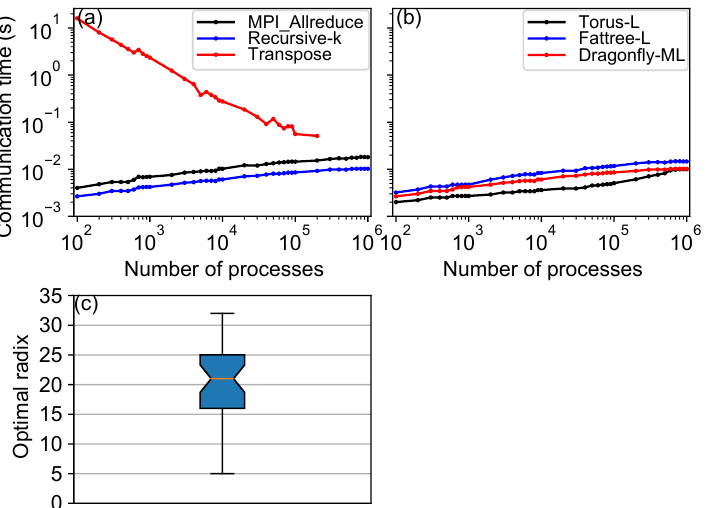
Figure 10. Panel (a) is the communication times of the allreduce operation using the MPI_Allreduce (black line) and the recursive- k algo- rithm (blue line), and the communication time of transposition for the spectral transform method is shown for comparison (red line). Panel (b) is the communication times of the allreduce operation using the recursive- k algorithm for the topology torus-L (black line), fattree-L (blue line), and dragonfly-ML (red line). Panel (c) is the statistics of the optimal radices for the recursive- k algorithm. The circle markers in (a) – (b) indicate the numbers of processes of the corresponding